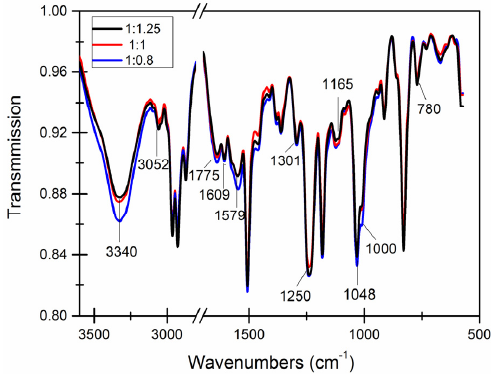
Figure 13. Infrared spectroscopy of microcapsules with different core ‐ wall ratios.